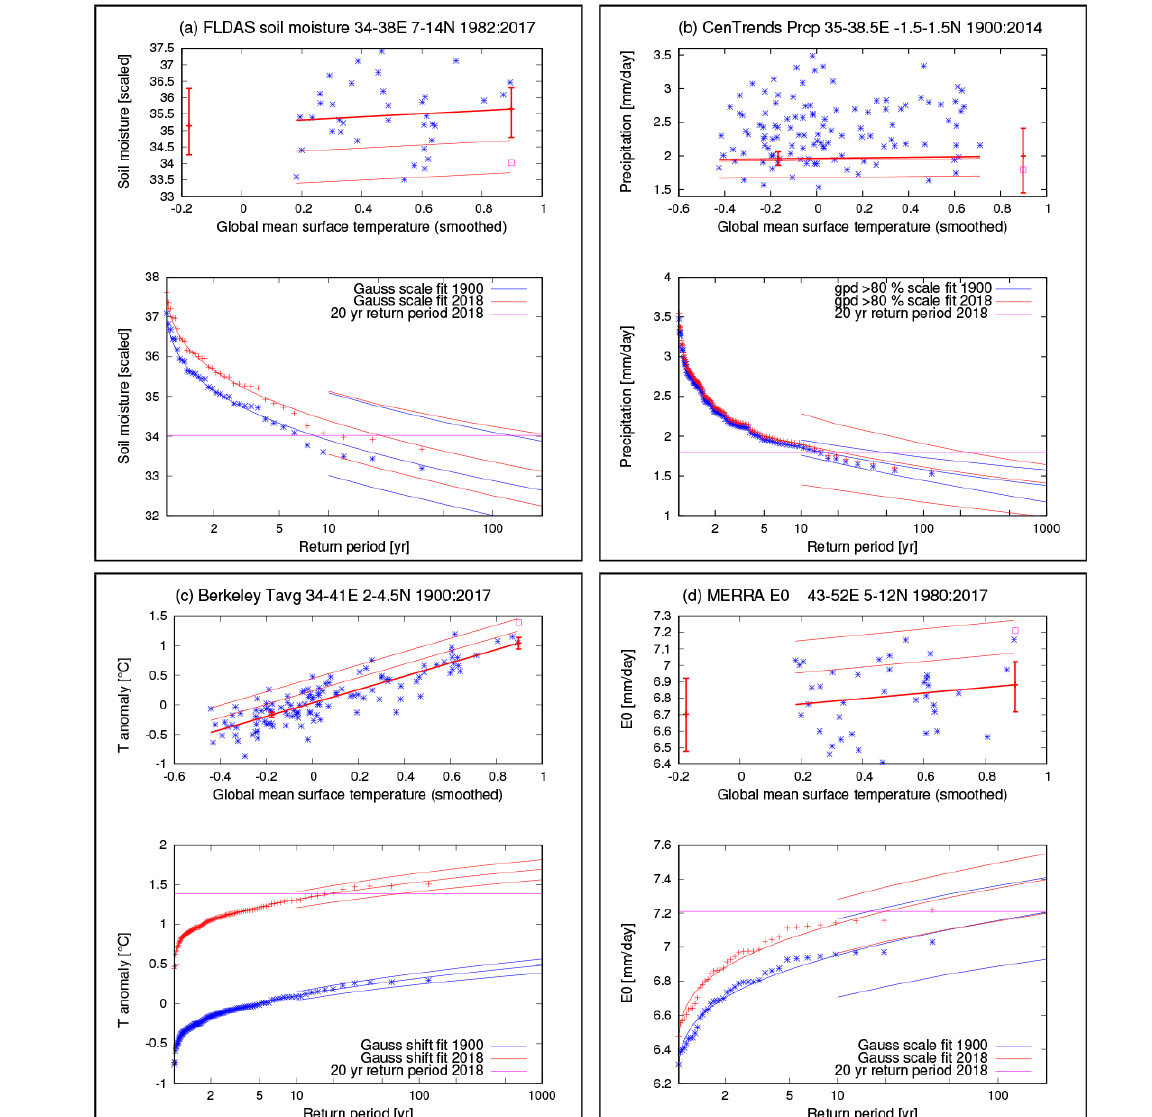
Figure 3. Illustrative examples of the fitting method for each variable for selected study regions: (a) FLDAS soil moisture (Gaussian fit, low extremes, region WE); (b) CenTrends precipitation (GPD fit, low extremes, region CK); (c) Berkeley temperature anomaly (Gaussian fit, high extremes, region NK); (d) MERRA E 0 (Gaussian fit, high extremes, region NS). At the top of each panel the following information is given: annually averaged data (stars) against GMST and fit lines – the location parameter µ (thick), µ ± σ and µ ± 2 σ (thin lines, Gaussian fits) and the 6- and 40-year return values (thin lines, GPD fit). Vertical bars indicate the 95% confidence interval on the location parameter µ at the 2 reference years 2018 and 1900. The magenta square illustrates the magnitude of an event constructed to have a 20-year return period in 2018 (not included in the fit). At the bottom of each panel the following information is given: return period diagrams for the fitted distribution and 95% confidence intervals, for the reference years 2018 (red lines) and 1900 (blue lines). The annually averaged data is plotted twice, being shifted or scaled with smoothed global mean temperature up to 2018 (red stars) and down to 1900 (blue stars). The magenta line illustrates the magnitude of a hypothetical event with a 20-year return period in